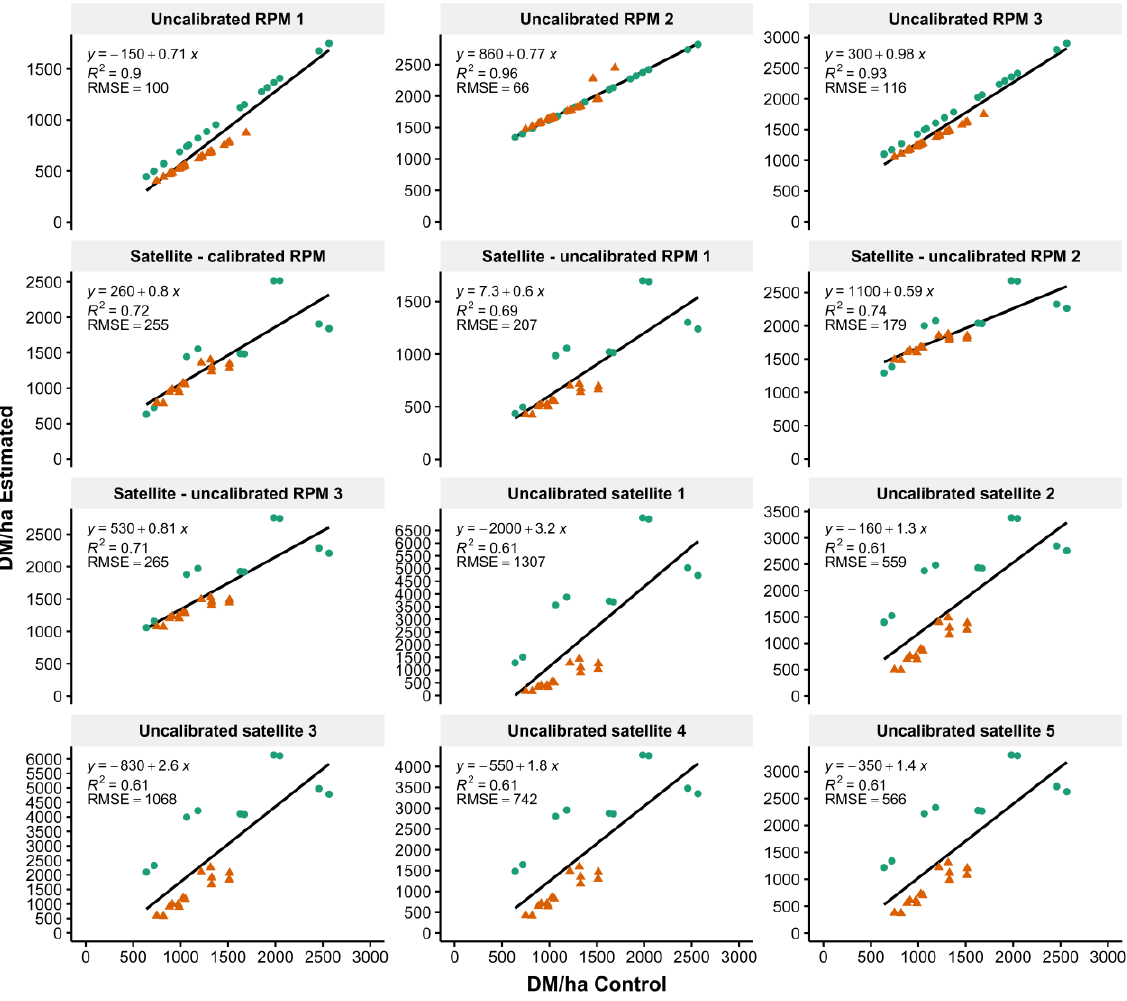
Figure 7. Linear regressions show the comparison of di ff erent calibration methodologies (DM / ha estimated) against the calibrated rising plate meter (DM / ha Control). Uncalibrated RPM = rising plate meter calibrated with standard equations ( RPM 1 : daily equation, RPM 2: monthly equation, RPM 3 : Annual equation). Satellite-calibrated RPM = satellite calibrated with a calibrated rising plate meter. Satellite-uncalibrated RPM = satellite calibrated with a rising plate meter calibrated with standardized equations. Uncalibrated satellite = satellite calibrated with a standard NDVI to biomass equations. Observations for regrowth 1 ( • ) and regrowth 2 ( (cid:78) ) are shown in the figures, together with the regression equations, coe ffi cients of determination (R 2 ), and the root means square errors